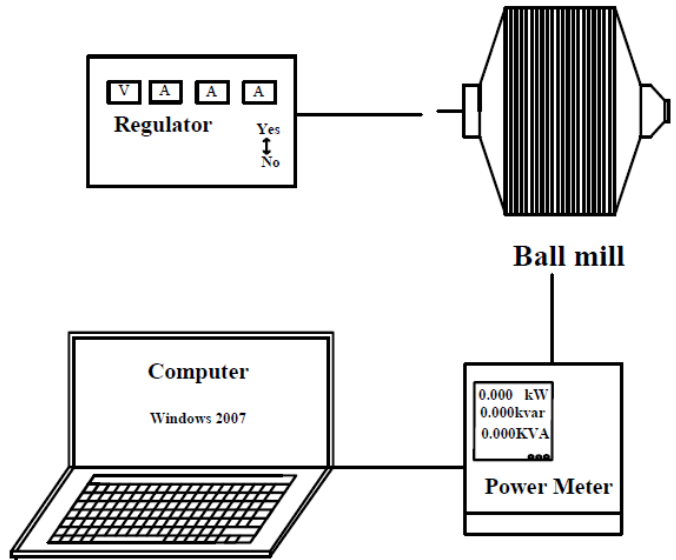
Figure 3. Conical ball mill grinding device sketch.